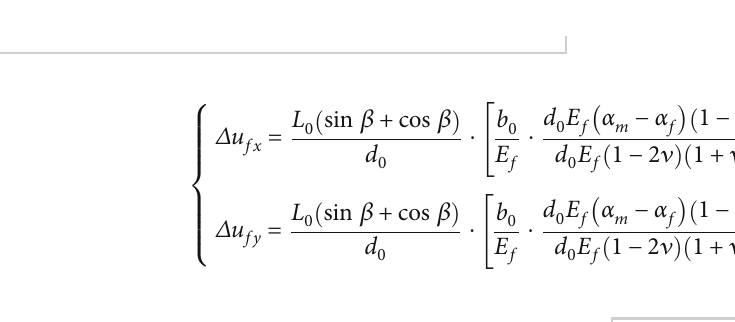
Figure 4: Plexiglass